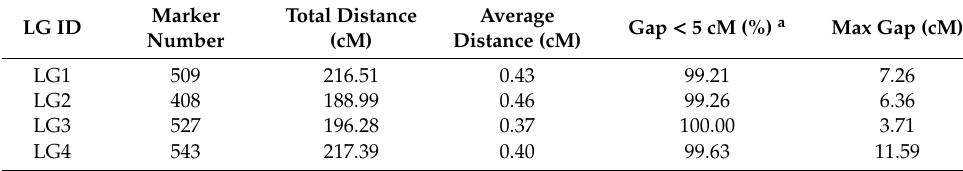
Table 2. Basic characteristics of the integrated linkage map of L. principis-rupprechtii